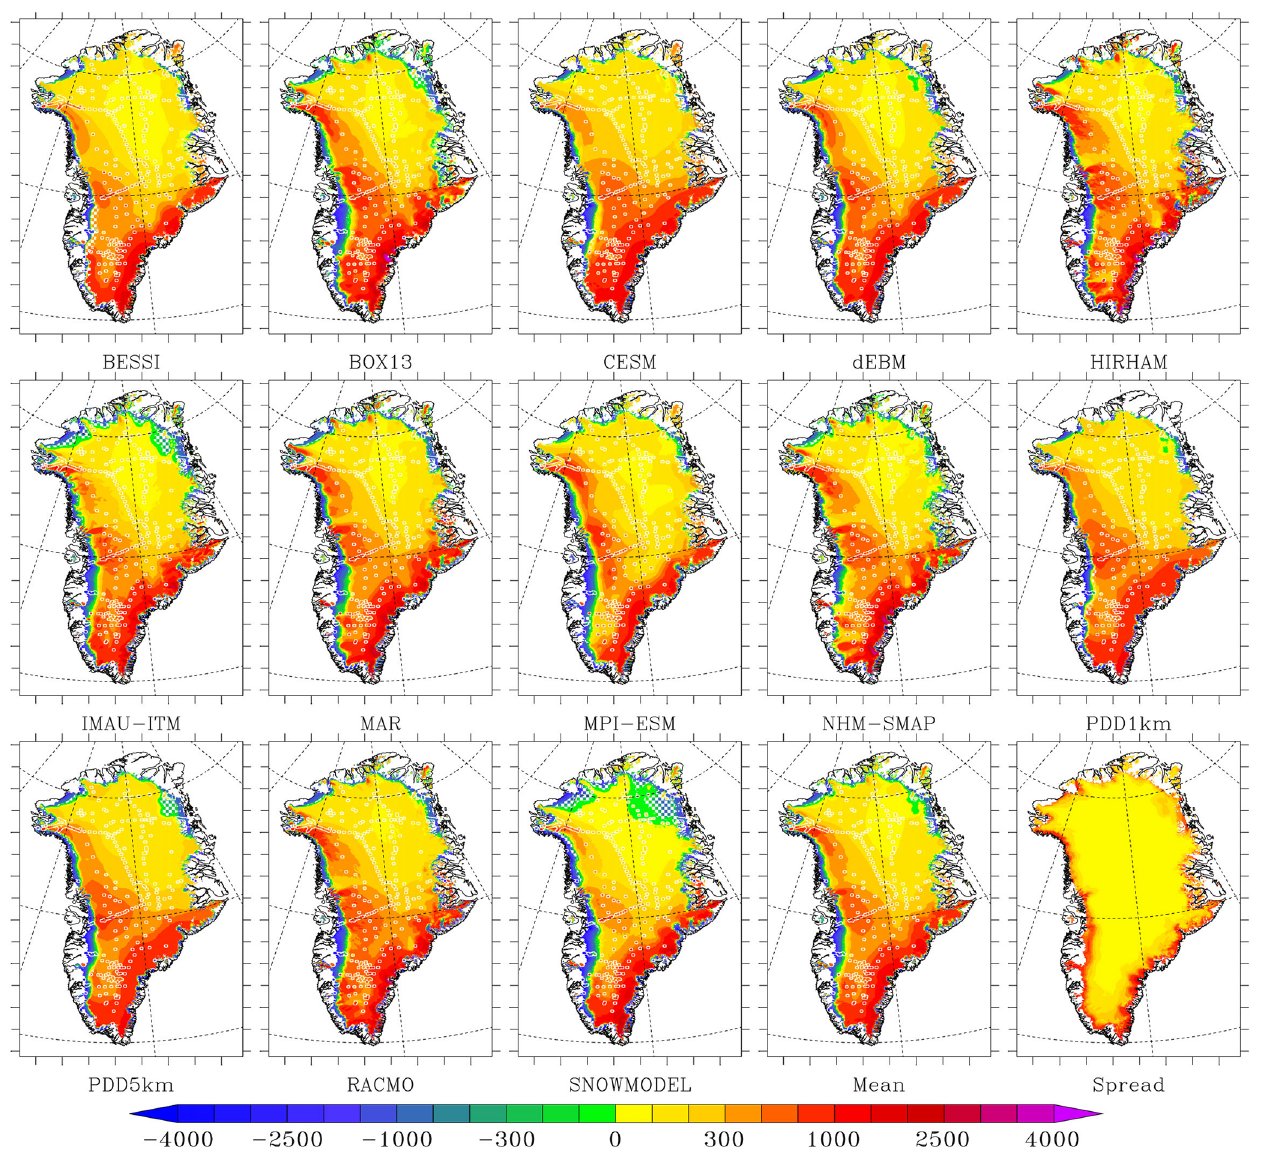
Figure 1. Mean SMB (in mmw.e.yr − 1 ) over 1980-2012 simulated by the 13 models as well as the ensemble model mean and the spread around this mean. The SMB measurements (ice cores + PROMICE) used to evaluate the models are represented as white circles. The areas listed in Table 4 where SMB disagree with the satellite-derived bare ice area are shown in a hatched area. Finally, it is important to note that for better visibility, the scale is not linear as it uses a step of 100 for absolute values lower than 500mmw.e.yr − 1 and a step of 500